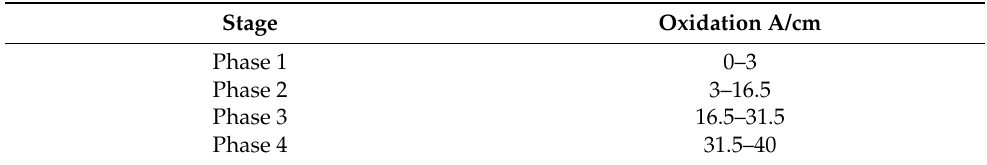
Table 2. Four different phases of oil oxidation